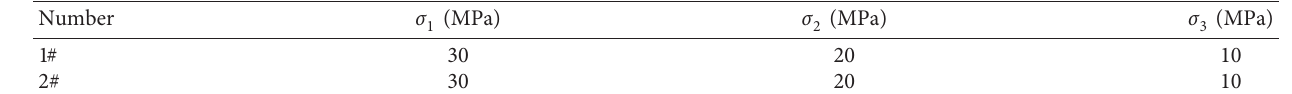
Table 1: The initial stress